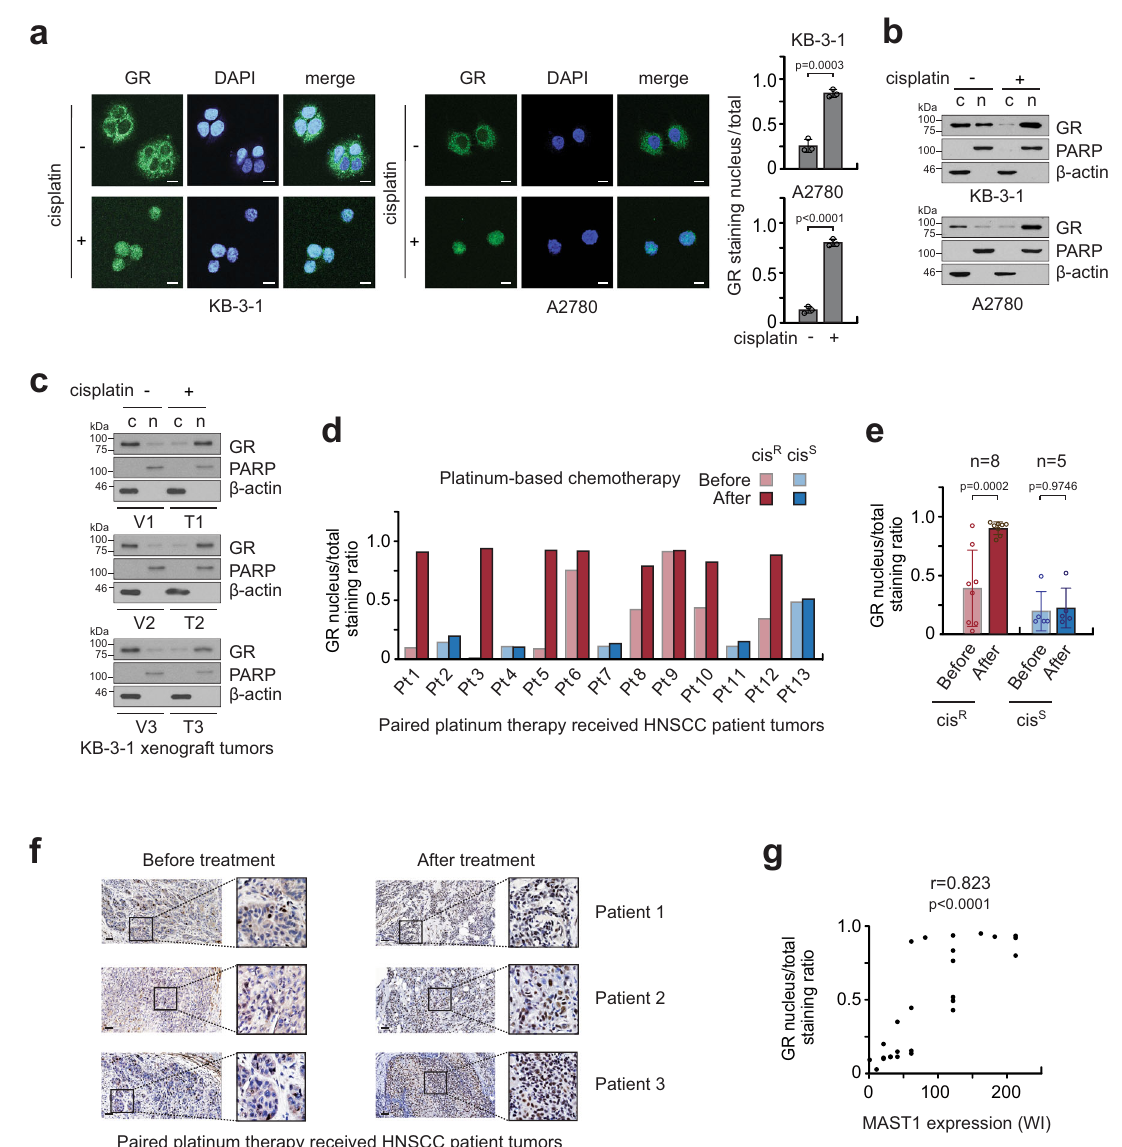
Fig. 3 Cisplatin induces GR nuclear translocation. a Immuno fl uorescence assay of GR in KB-3-1 and A2780 cells before and after cisplatin treatment. Nuclei were DAPI stained. b Western blots show the cytosolic and nuclear localization of GR upon cisplatin treatment in KB-3-1 and A2780 cells. PARP and β -actin were used as control markers for nucleus and cytosol, respectively. c: cytosol, n: nucleus. c GR localization in KB-3-1 xenograft tumors collected from cisplatin-treated (T1 – T3) and vehicle-treated (V1 – V3) mice. d and e Nuclear staining of GR in paired HNSCC patient tumor tissues collected before and after platinum treatment. The patients were either “ Resistant (cis R ) ” or “ Sensitive (cis S ) ” to platinum-based therapy. Images were quanti fi ed with ImageJ software. f Representative GR staining images of paired HNSCC patient tumors are shown. g The correlation between MAST1 expression and GR nuclear staining in paired tumor tissues of HNSCC patients receiving platinum therapy. Scale bars represent 10 μ m for a and 50 μ m for f . Data are mean ± SD from three random selected areas for a , from one and three biological replicates for b and c , and n = 8 (cisplatin-resistant) and n = 5 (cisplatin- sensitive) patients for e . Three representative tumors from 13 cases are shown for each group (before/after platinum therapy) for f . Statistical analyses were performed by unpaired two-tailed t -test for e and two-tailed Pearson ’ s correlation coef fi cient for g . Source data are provided as a Source Data fi